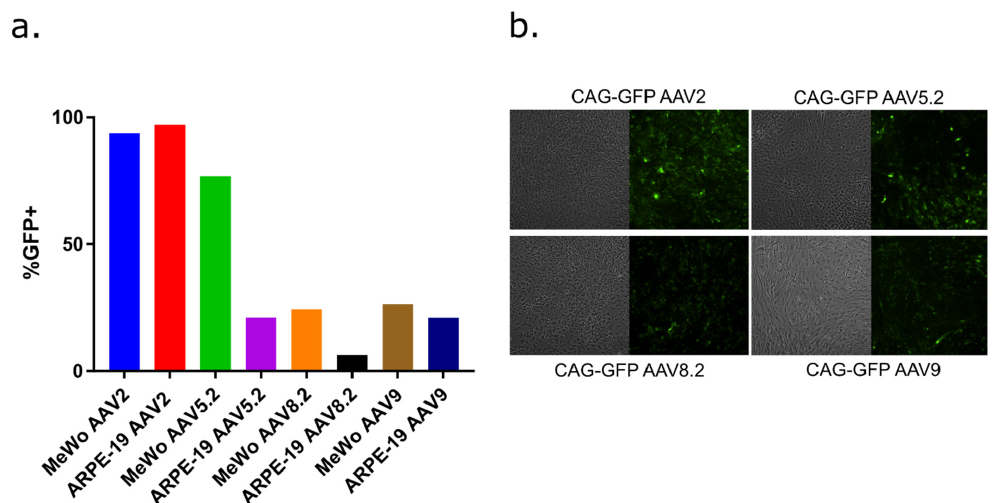
Figure 2. A preliminary study of AAV serotypes able to deliver to epithelial cells and neurons. ( a ) The fraction of two VZV permissive epithelial cell lines (MeWo and ARPE-19) that expressed GFP, as determined by flow cytometry, after infection with 5 μ L of 10 12 GC/mL AAV per well of a 6 well plate with AAV-GFP serotypes 2, 5.2, 8.2 or 9. AAV-mediated expression was measured by flow cytometry at 3 days post transduction and is represented as a fraction of the total cell population, using gates selected by analyses of untransduced cells. Of the four serotypes evaluated on MeWo and ARPE-19 cells, AAV-2 was the most efficient at transducing both cell types to express GFP. The study represents single transductions and was not statistically evaluated. ( b ) To qualitatively establish the transduction of hESC-derived neurons, neurons cultured in 12-well dishes were transduced with 1.25 × 10 11 GC per 12-well of each GFP-expressing AAV serotype. The AAV-mediated expression of GFP was imaged at multiple (>5) non-overlapping random positions at 6 days. Representative images are shown that reflect GFP expression in neuron cultures. Further quantification could not be determined due to the heterogeneous and three-dimensional nature of the neuron